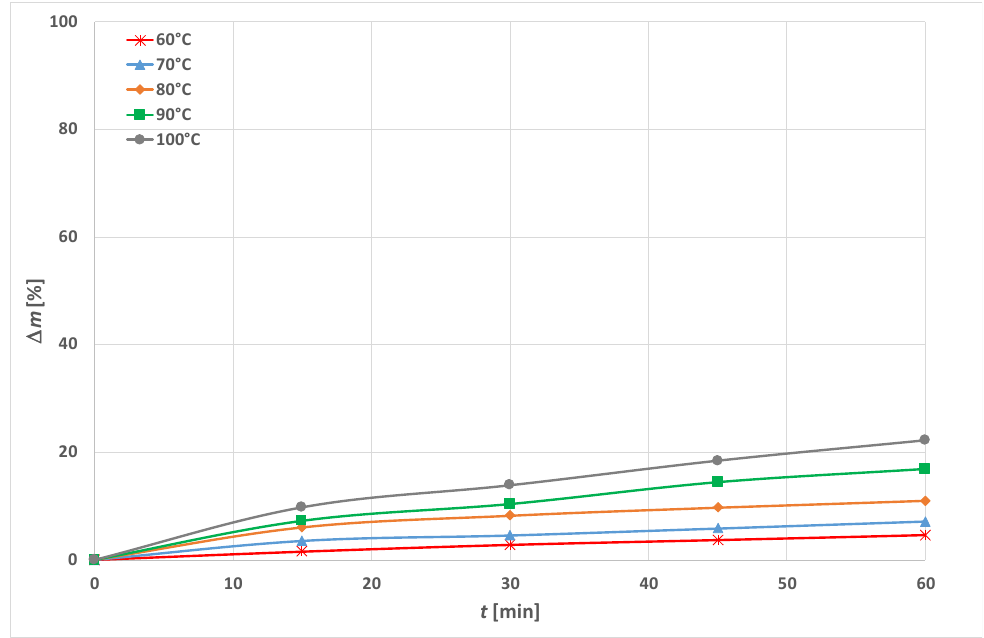
Figure 3. Dissolution of PET fibers in 1.5 mol cm − 3 NaOH at temperature range 60 to 100 °C expressed as weight loss ( Δ m ).